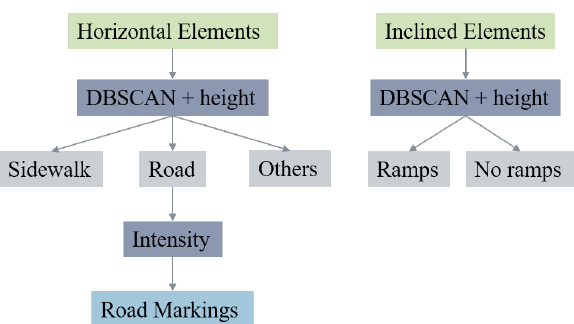
Figure 3. Horizontal and inclined elements classification